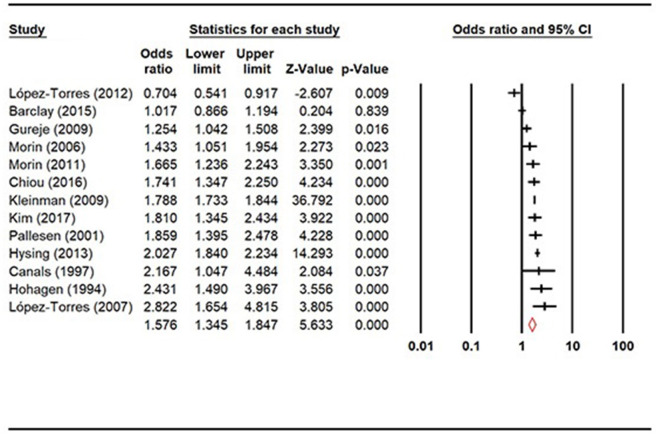
Forest plot of gender difference in the prevalence of insomnia.